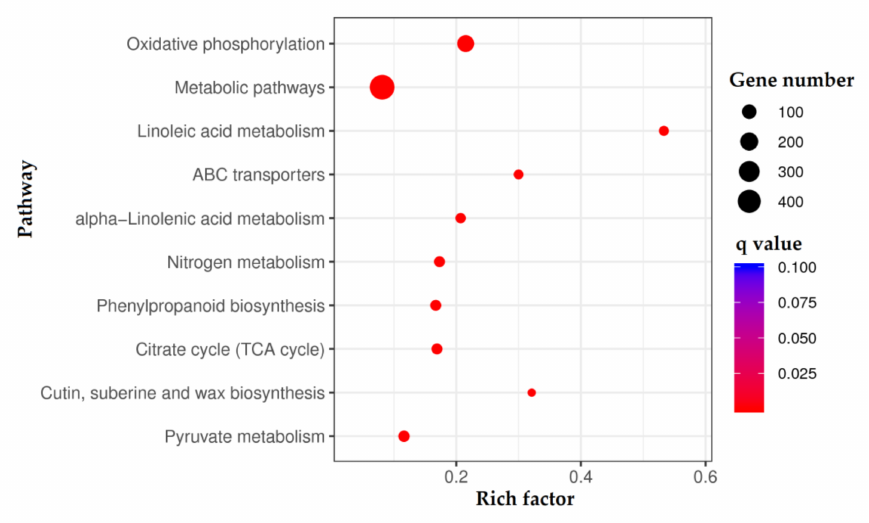
Figure 6. Top 10 pathways of KO enrichment of the